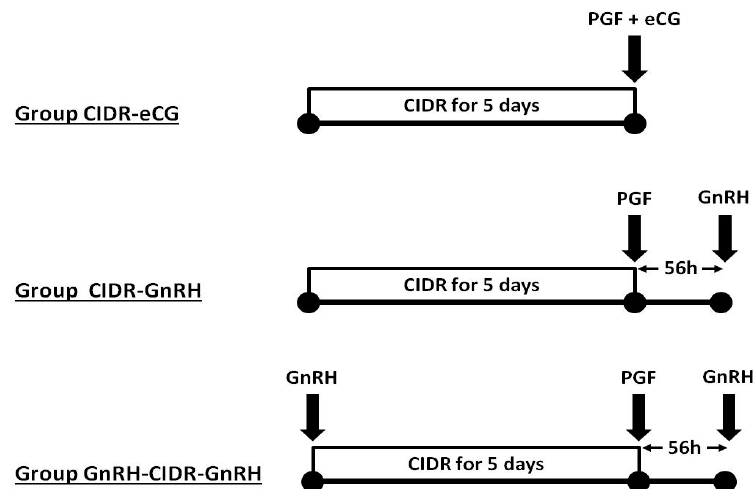
Figure 1. Schematic representation of the three treatment groups compared in the study. All the groups were treated with controlled internal drug release (CIDR) devices for 5 days and a prostaglandin F 2 α injection at CIDR removal. The CIDR-equine chorionic gonadotrophin (eCG) group was treated with a single intramuscular (i.m.) dose of 400 IU of eCG at CIDR removal, the CIDR-gonadotrophin-releasing hormone (GnRH) group was treated with a single dose of GnRH at 56 h after CIDR removal, and the GnRH-CIDR-GnRH group was treated with two single GnRH doses—one at CIDR insertion and one 56 h after CIDR removal.